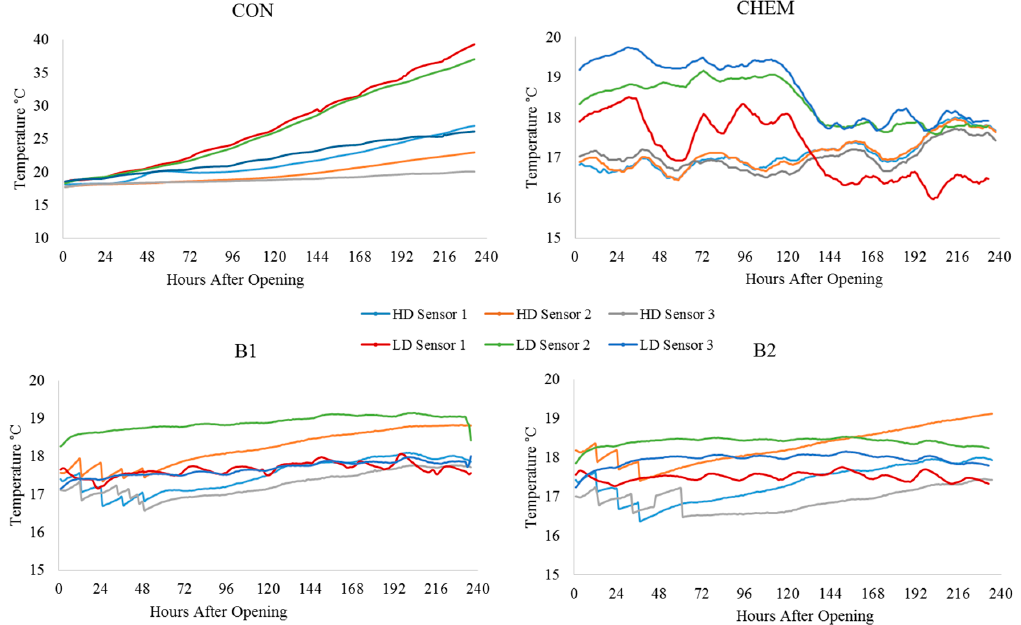
Figure 2. Temperature means per sensor, obtained from hourly average of temperature data measured in different treatments; CON = control group, CHEM = silage treated with the chemical additive, B1 = silage treated with biological additive 1, B2 = silage treated with biological additive 2, HD = high density, LD=low density.